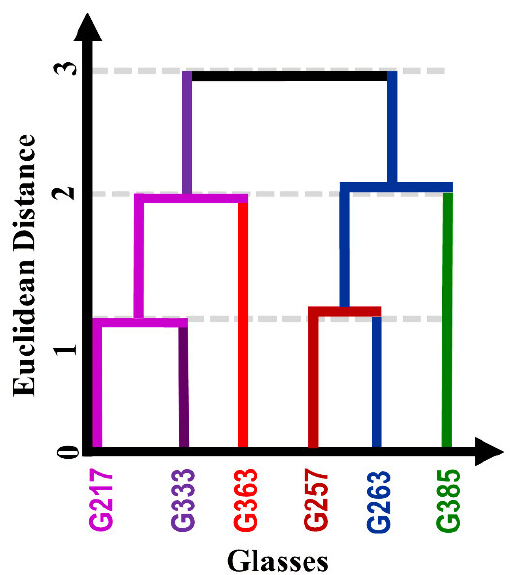
Figure 3. Schematic dendrogram of the first six glasses of all 479 glass substances analyzed considering Euclidean distance and the linkage method. For example, from these data, it was possible to verify that glasses G217 and G333 were the most similar due to the smallest Euclidean distance considering 479 glass systems and 51 variables, thus promoting the first clustering stage. The difference between these compositions relates to small amounts of PuO 2 and ThO 2 , of less than 0.03 wt%, as presented in Supplementary Table